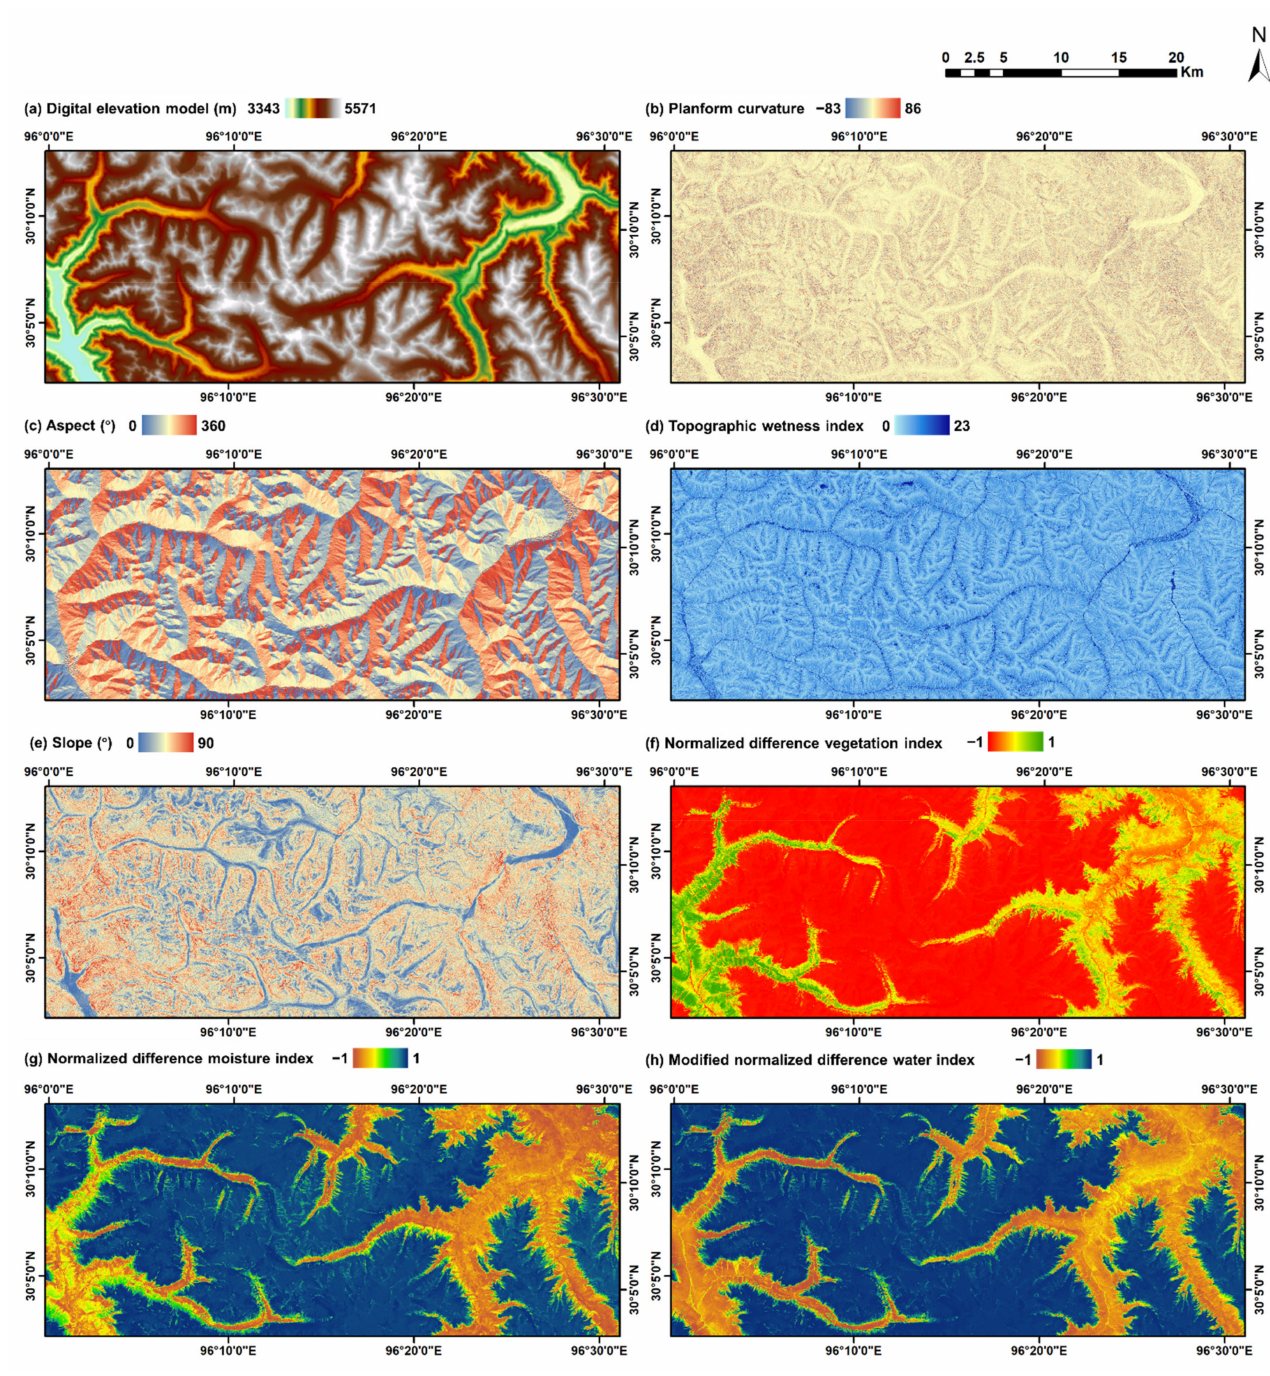
Figure 3. Data layers of the study area: ( a ) digital elevation model; ( b ) planform curvature; ( c ) aspect; ( d ) topographic wetness index; ( e ) slope; ( f ) normalized difference vegetation index (NDVI); ( g ) normalized difference moisture index (NDMI) and ( h ) modified normalized difference water index (MNDWI). (The digital elevation model is acquired from the Alaska Satellite Facility Distributed Active Archive Center and originated from the National Aeronautics and Space Administration Shuttle Radar Topography Mission Global 1 arc second product. The Sentinel-2B multi-spectral image, which is used to produce the NDVI, NDMI and MNDWI layers, is acquired from the Copernicus Open Access Hub of the European Space